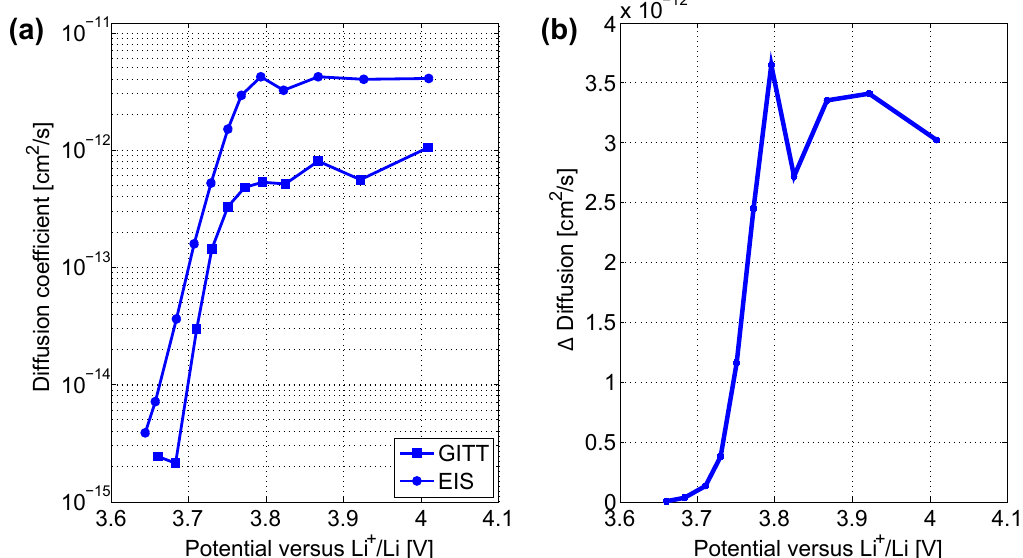
Figure 10. ( a ) Diffusion coefficients in uncycled positive electrodes from GITT and EIS characterisations. ( b ) Difference between the two characterisation